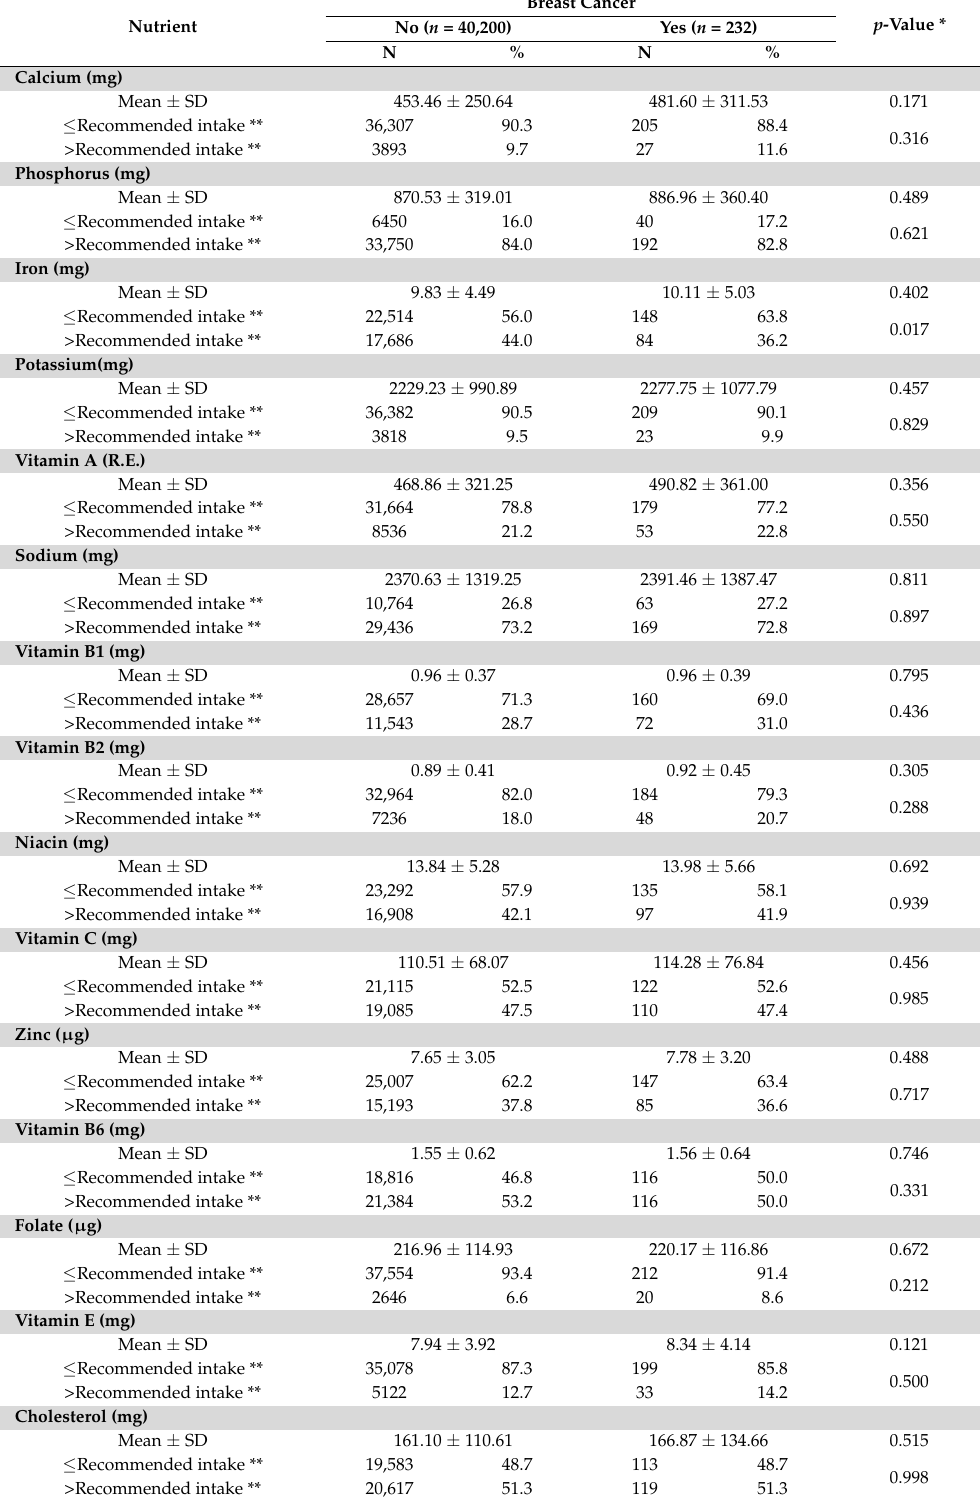
Table 2. Comparison of nutrient intake recommendations for patients with breast cancer.